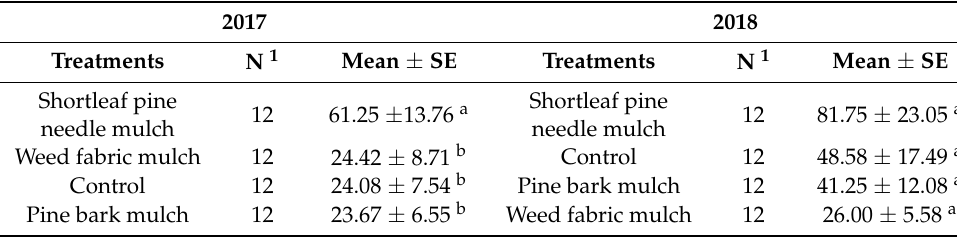
Table 1. Average numbers of adult D. suzukii caught on blueberries in different mulching practices using Suzukii ® bait traps during the sampling periods in 2017 and 2018.